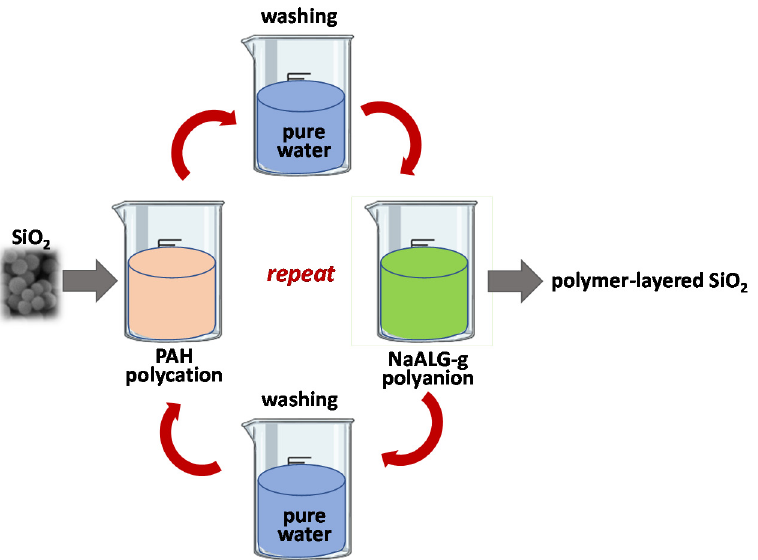
Scheme 1. Schematic representation of the LbL method for the fabrication of SiO 2 @polymer hybrid